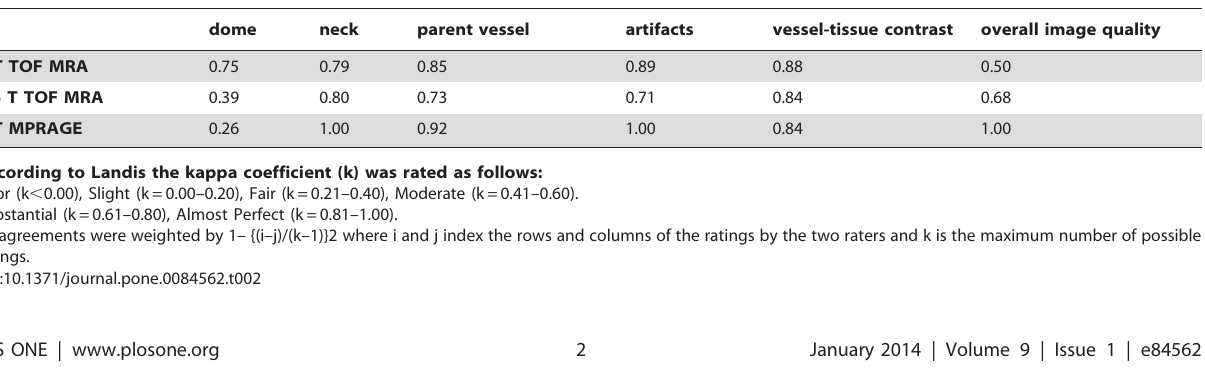
dome neck parent vessel artifacts vessel-tissue contrast overall image